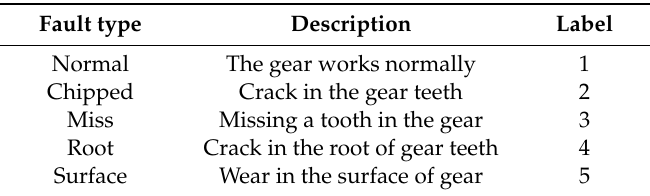
Table 5. Description of gear fault types.